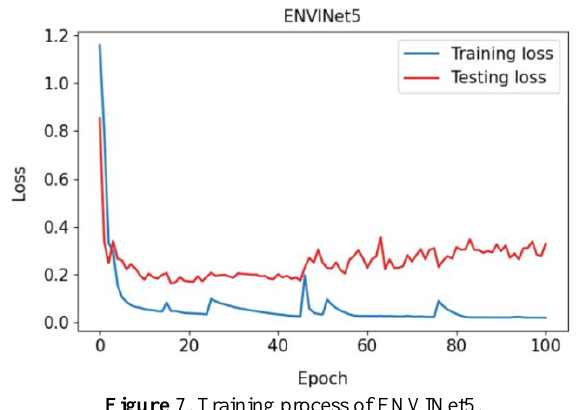
Figure 7. Training process of ENVINet5.